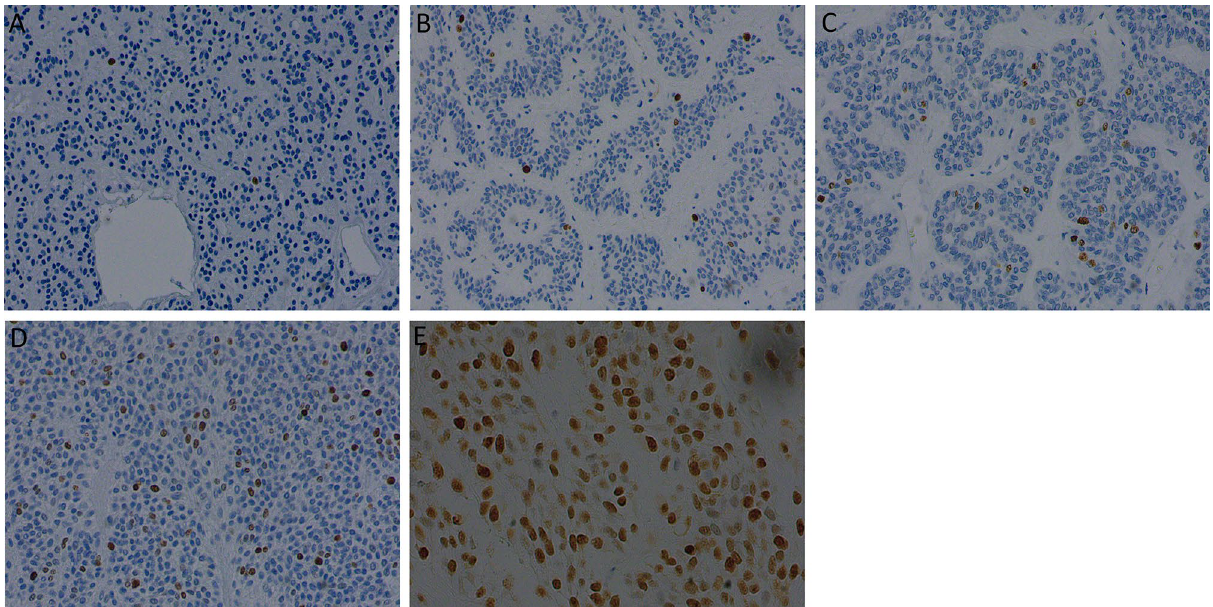
Figure 3. ( A–C ) Increasing MIB-1 proliferation index in consecutive PA recurrencies. ( A ) primary PA; ( B ) first recurrence; ( C ) later recurrence. ( D ) High MIB-1 in CxPA. ( A – D ) magnification ×200. ( E ) Nuclear cyclin D1 expression in CxPA. Magnification